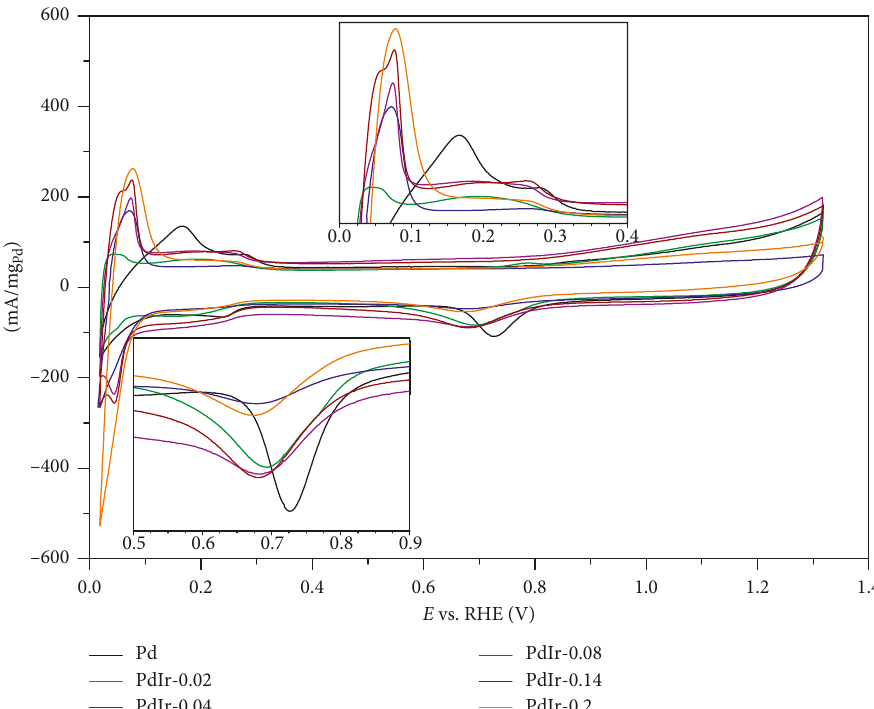
Figure 5: Cyclic voltammograms for mono Pd and bimetallic PdIr catalysts in N 2 -saturated 0.5M H 2 SO 4 solution with a scan rate of 50mV/s. The insets are magnified views of the hydrogen desorption region (0.0–0.4V) and the metal surface reduction region